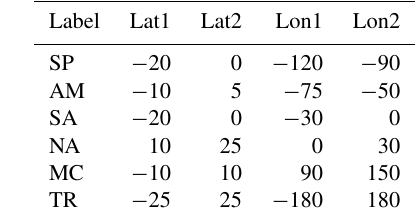
Figure 15. Diurnal peak time in local time for RH I based on Fourier series fit for the months of June and July. Depicts from top to bottom are for SAPHIR channels 1–6, respectively. Table 2. The regions selected based on mean and amplitude of tro- pospheric RH to investigate the diurnal variation of RH. The regions are labeled from west to east as South Pacific Ocean (SP), Amazon (AM), South Atlantic Ocean (SA), North Africa (NA), the Maritime Continent (MC), and entire Tropical Region (TR). These regions are indicated on all the maps.